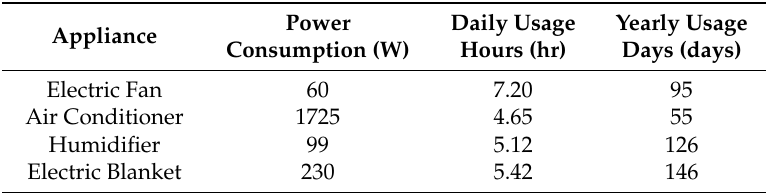
Table 3. Power consumption of seasonal electrical appliances.